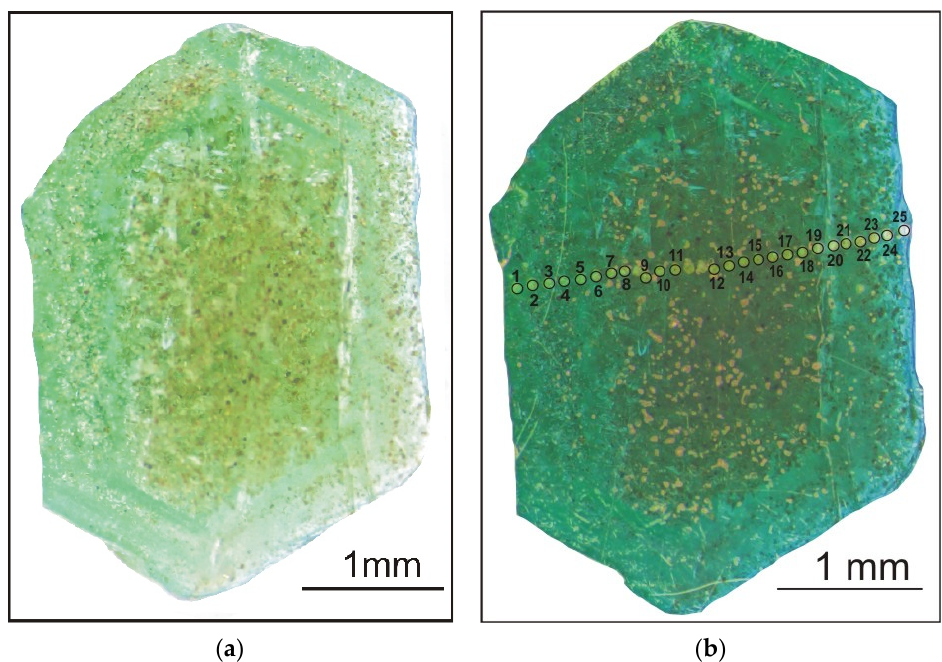
Figure 3. Natural zoned beryl crystal from the Wadi Nugrus, South Eastern Desert, Egypt, without gold coating ( a ) and transverse section of the studied beryl (with gold coating) and 25 analytical points ( b ).